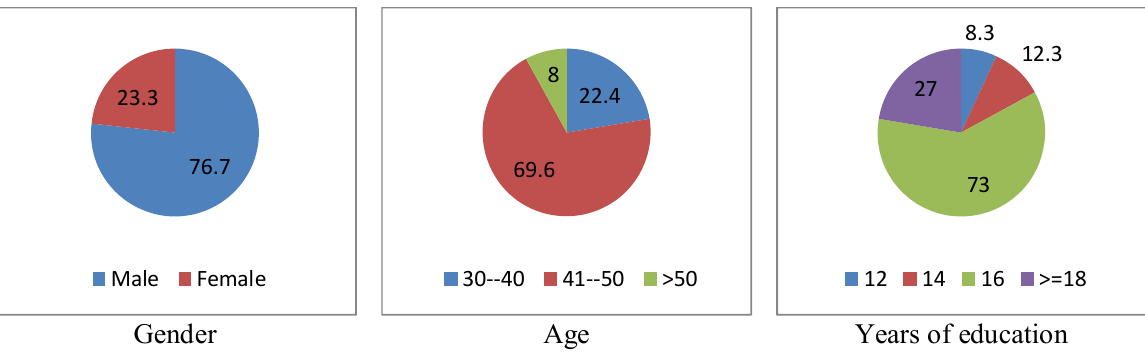
Fig. 1. Personal characteristics of the participants